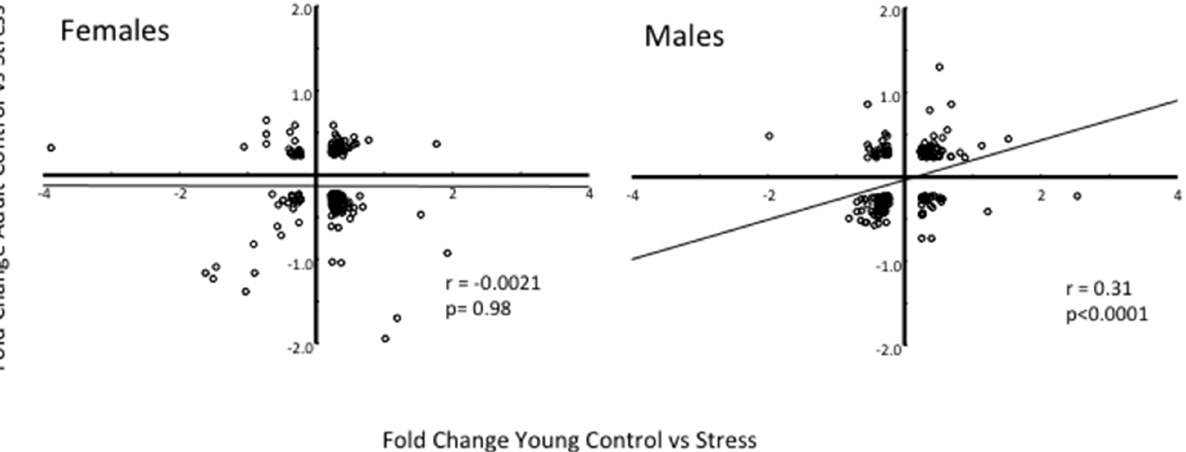
Fig 5. Correlation of differential expression of overlapping genes at 28 (young) and 213 (adult) days of age. The values of the axes represent the fold changes in the differential expression when comparing early stressed males and females. The plots show the correlations of the differential fold changes of the genes overlapping on the top 1000 differentially expressed at each age. The values for the young birds were obtained immediately after a 30 min physical restraint period as explained in Material and Methods, and in the adults they were obtained five minutes after capture and removal from the home